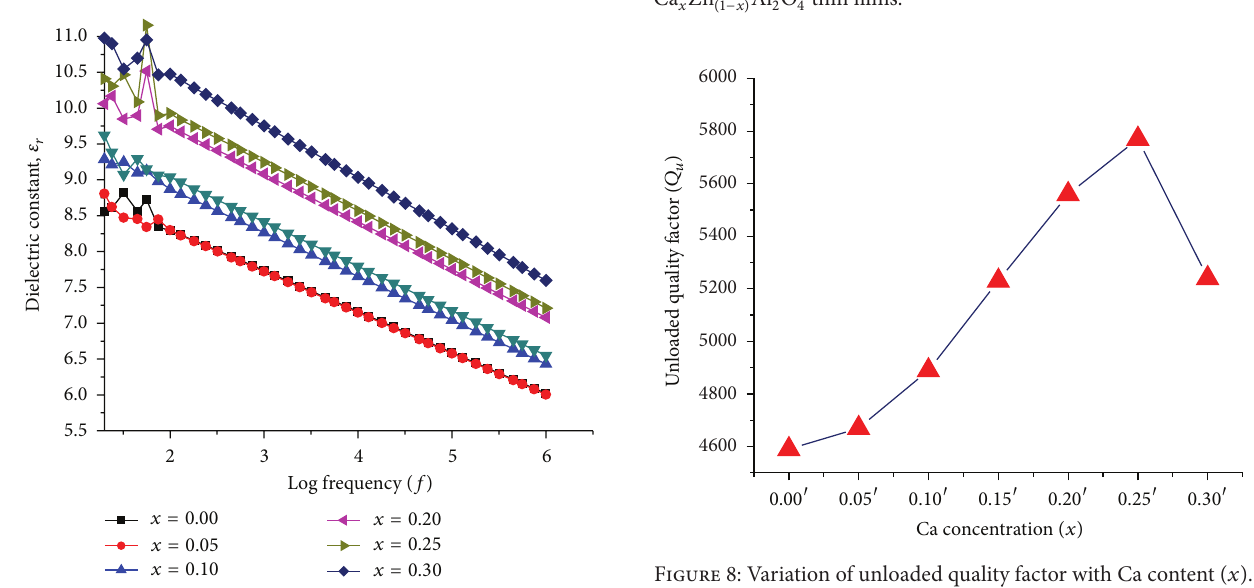
Figure 7: Apparent density and dielectric constants of Ca 𝑥 Zn (1−𝑥) Al 2 O 4 thin films.